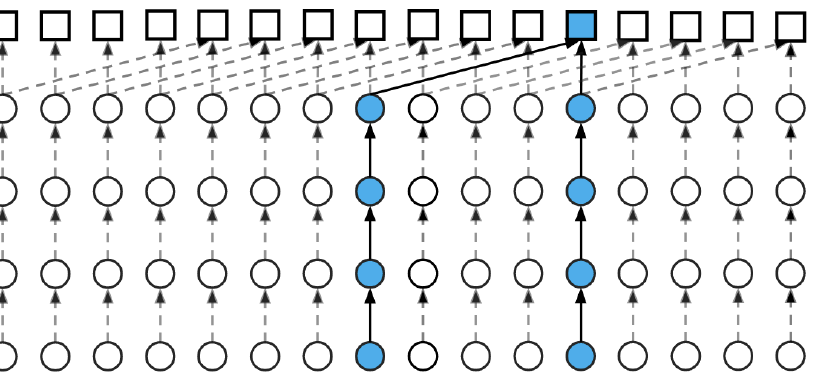
Figure 5. Learning process of late fusion (Note: Blue denotes the number of nodes needed in current operation).